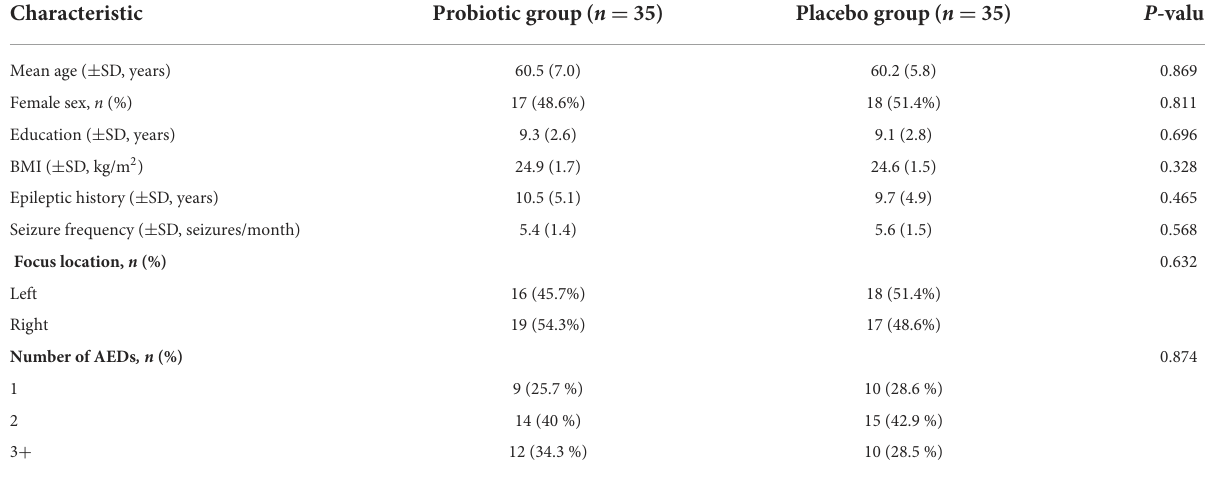
TABLE 1 Demographic and clinical characteristics of participants.